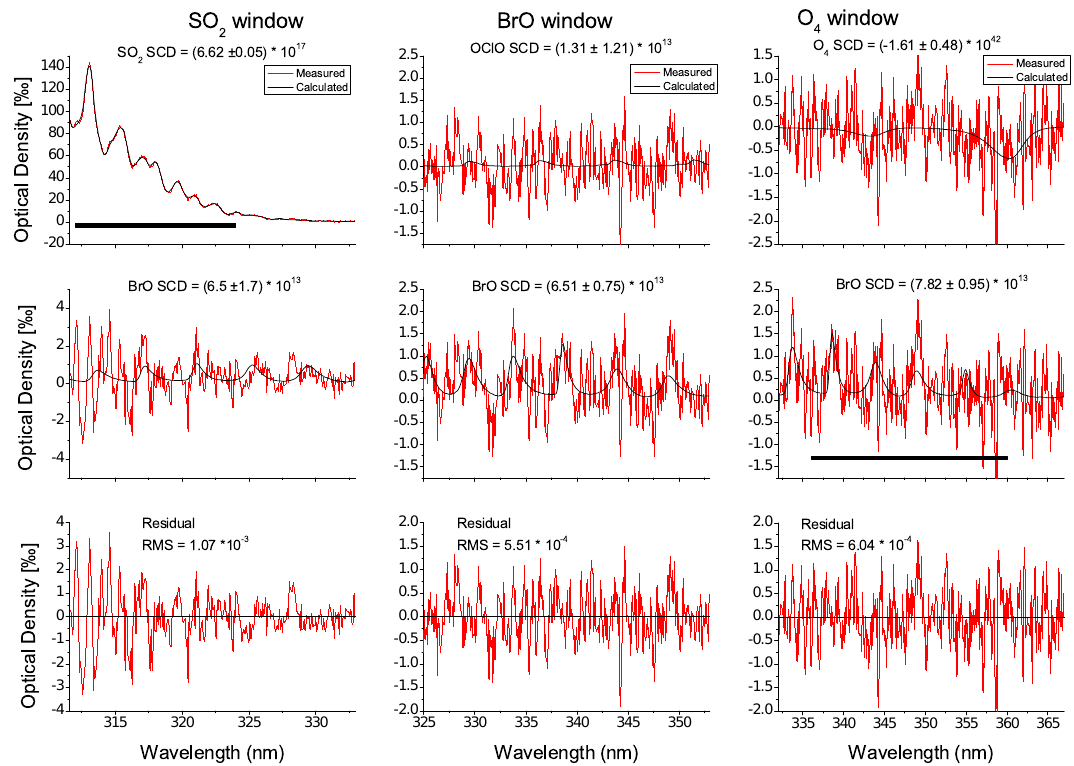
Fig. 1. Example fit for the three different wavelength intervals (shown in the three columns) for spectrum C4000160 (9 spectra co-added, 1 omitted 10:19:28 – 10:20:50 UT) of the nadir spectrometer (6.66 ◦ W, 56.14 ◦ N, 4580 m ASL – inside the plume). The black bars in the SO 2 and O 4 windows show the SO 2 and BrO fit window used in the GOME-2 retrieval (Table 1). within their errors. Also the BrO fit interval was extended towards shorter wavelengths, to check for the influence of the imperfect O 3 fit (Fig. 1 SO 2 window). Until ≈ 320 nm no significant change in the BrO SCDs was